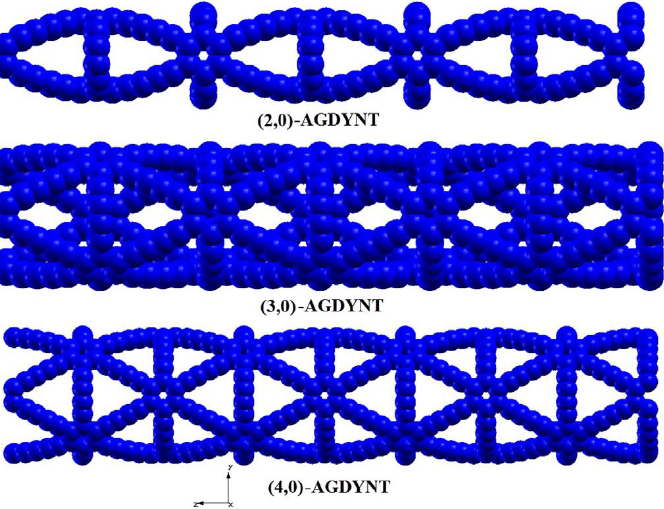
Figure 18. Examples of optimized armchair graphdiyne nanotubes (AGDYNTs). Reproduced from [47] with permission from Elsevier. Copyright 2016.